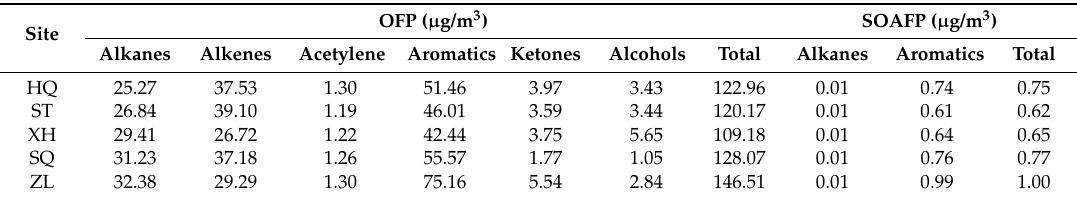
Table 1. The oxidation formation potential (OFP) and secondary organic aerosol formation potential (SOAFP) for different VOC categories at each